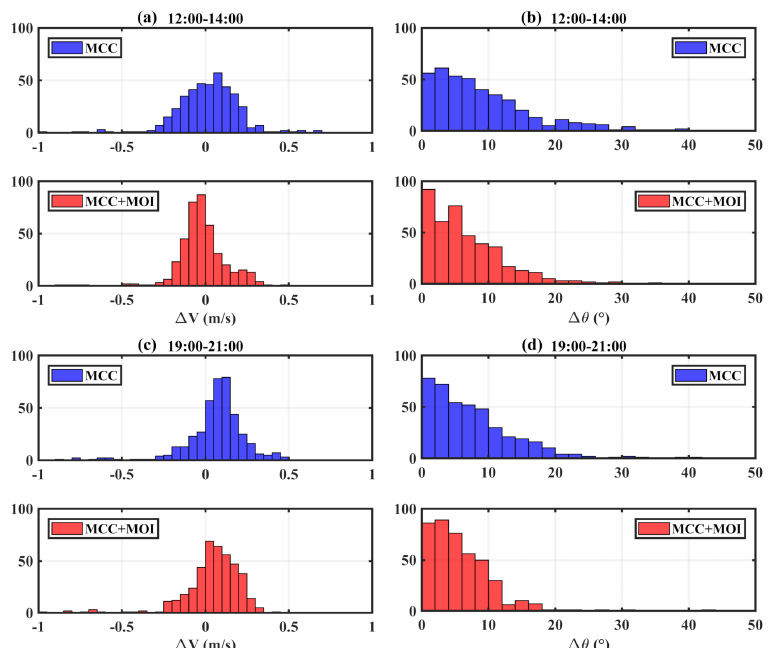
Figure 4. Histograms of magnitude and angle differences between the MITgcm model velocities and those from either MCC or MCC+MOI on 13 September 2011. For this histogram comparison, the total number of model vectors equals those estimated using MCC and